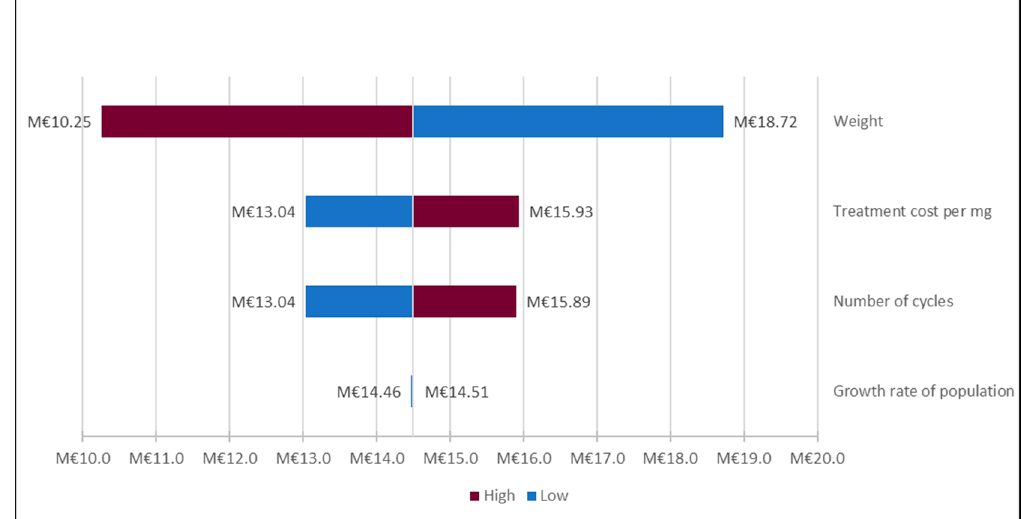
Figure 4. Tornado chart: univariate deterministic sensitivity analysis comparing the influence of different parameters on cost-savings.